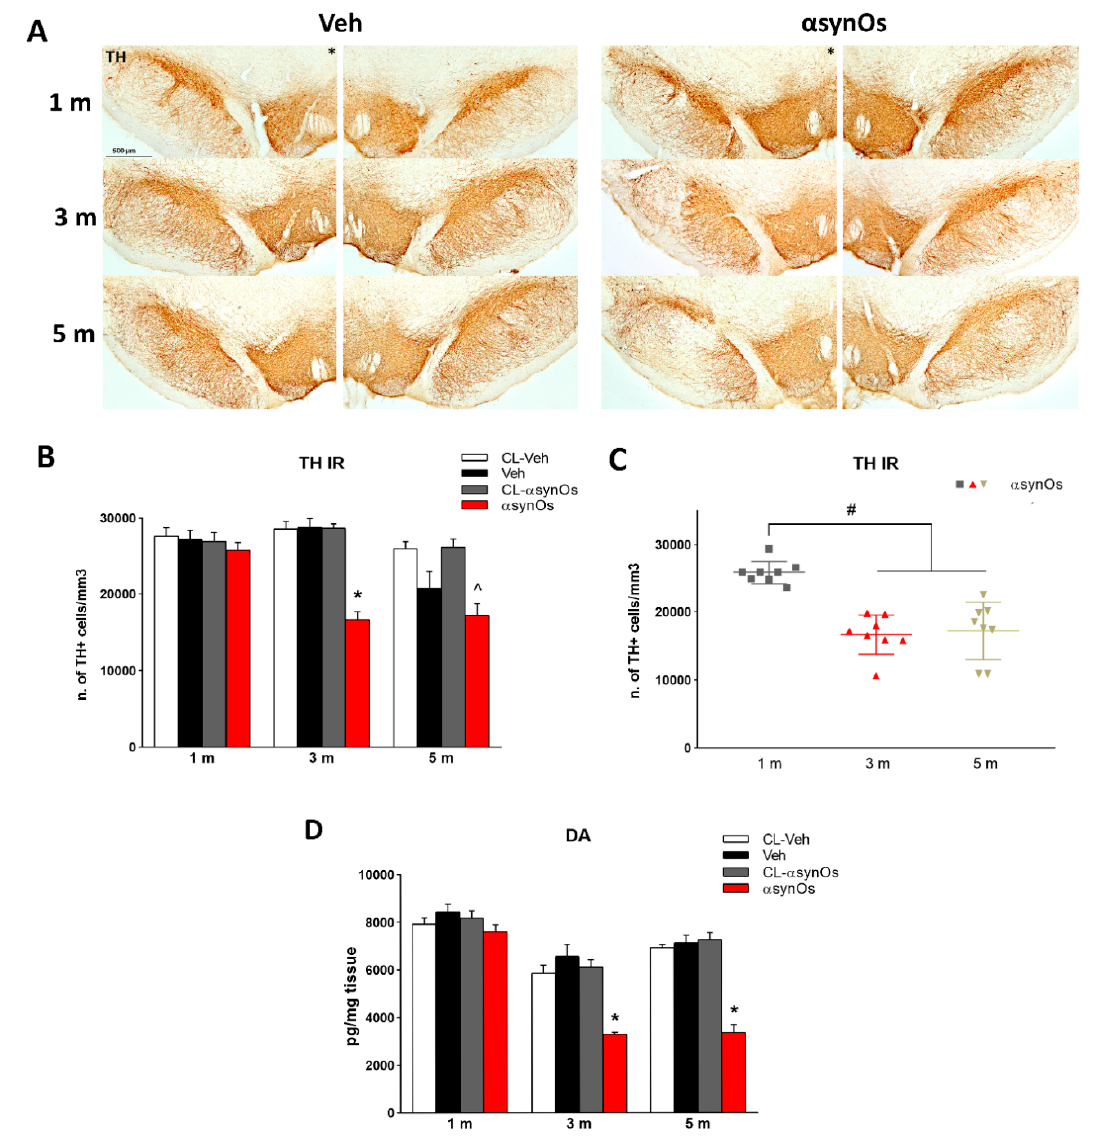
Figure 7. H- α SynOs induced a progressive nigrostriatal degeneration. Tyrosine hydroxylase ( TH) immunostaining in the SNpc of vehicle and H- α synO-infused rats (marked with *). (Magnification 5X) ( A ). Number of TH + cells / mm 3 measured by stereological counting, one, three, and five months after the H- α SynOs or vehicle infusion ( B ). Scatter plots shows the time-dependent progression of cell loss in the SNpc ( C ). Striatal dopamine content one, three, and five months after H- α SynOs or vehicle infusion ( D ). Values represent the mean ± SEM. * p < 0.0001 vs. all other groups in the same time point, ˆ p < 0.0001 vs. CL-H- α SynOs, # p < 0.0001 vs. Veh and H- α SynOs one month post infusion (1 m) by Tukey post-hoc test ( n = 8 per group).